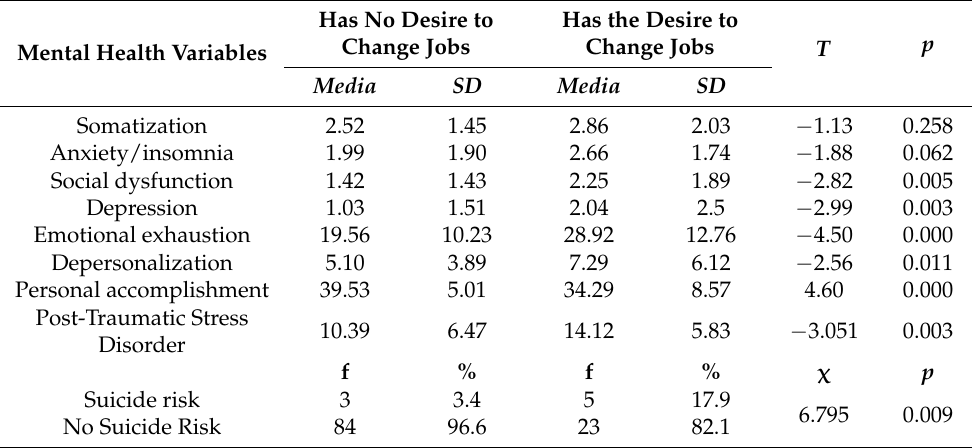
Table 5. Mean differences according to desire change job and mental health.